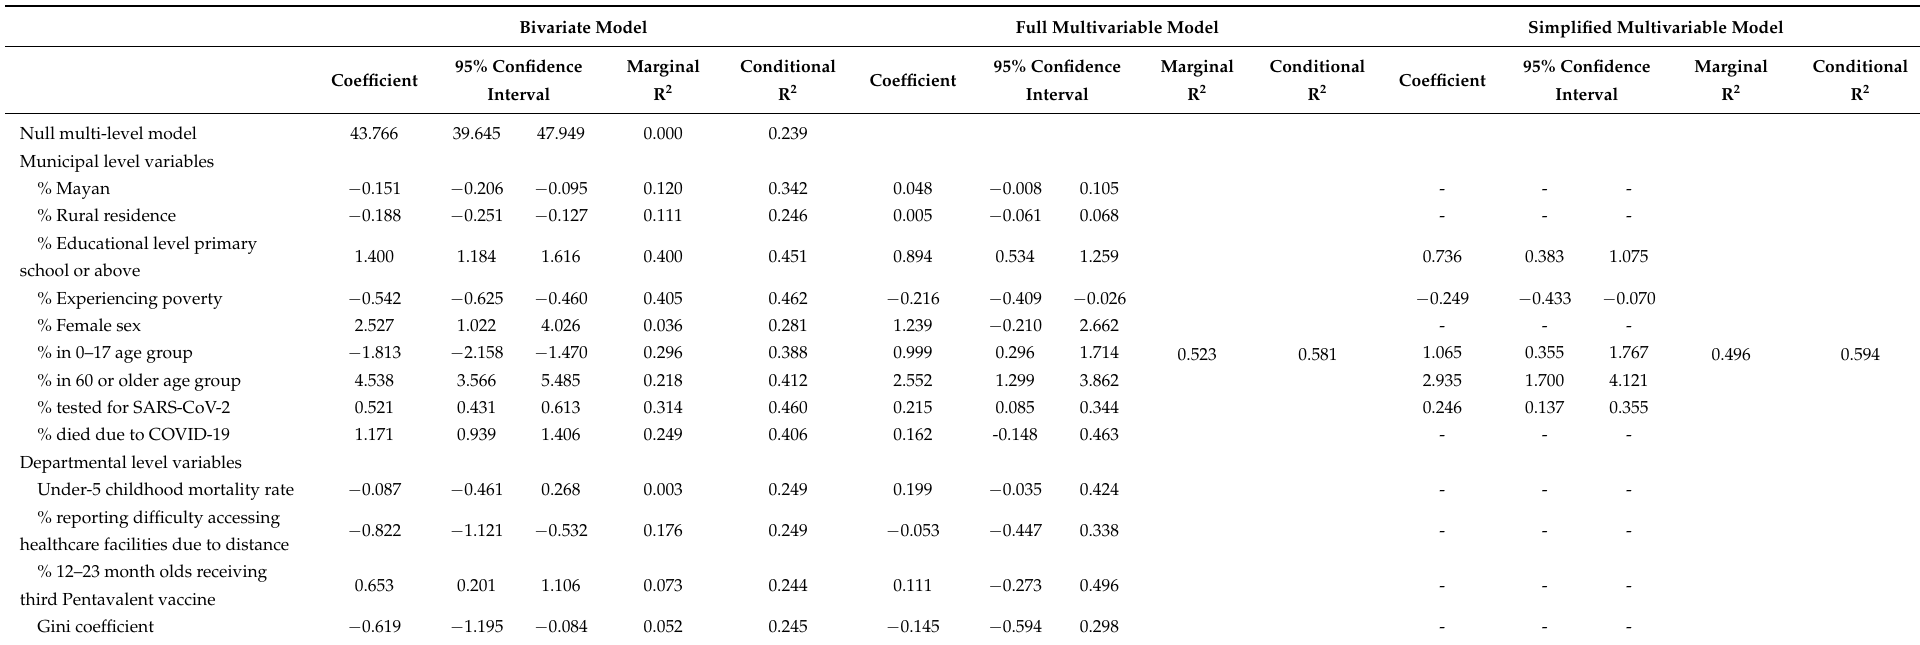
Table 3. Association between sociodemographic factors (by municipalities and departments) and two-dose vaccination coverage (%) by municipalities in Guatemala (N = 336). SARS-CoV-2 case and vaccination data are from 13 February 2020 to 30 November